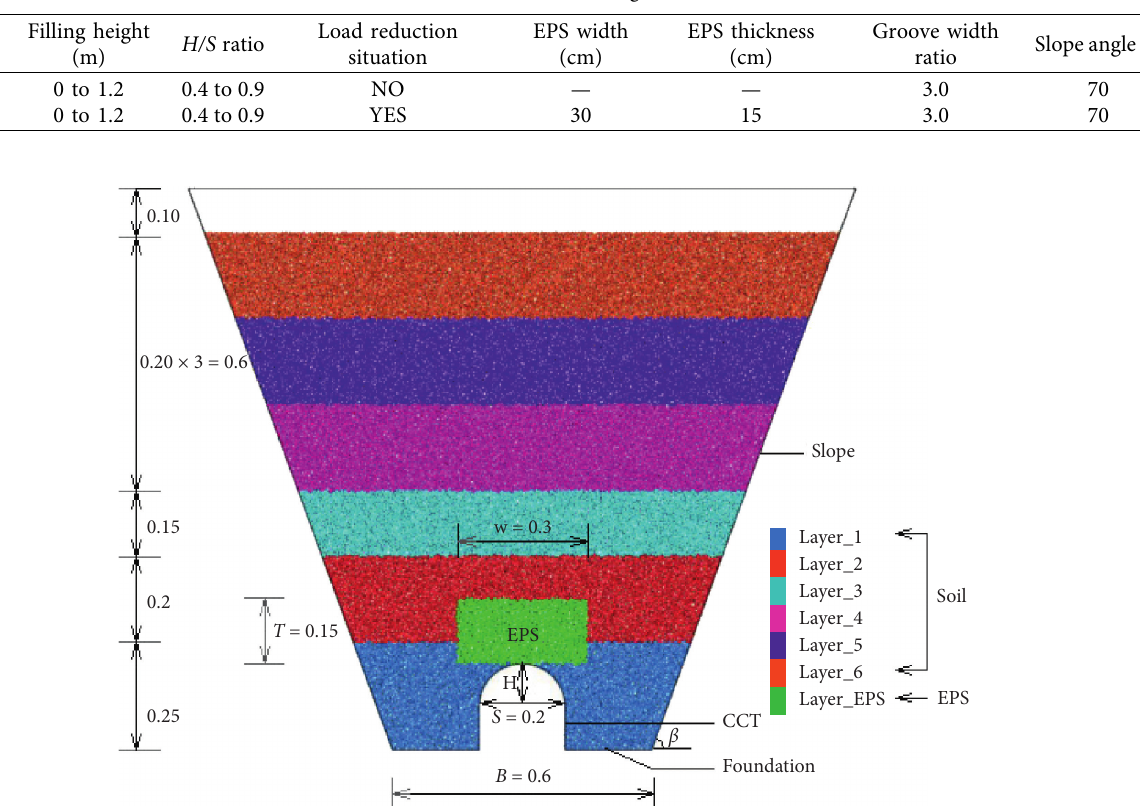
Figure 1: Schematic showing the discrete element model for a CCT (unit: m).